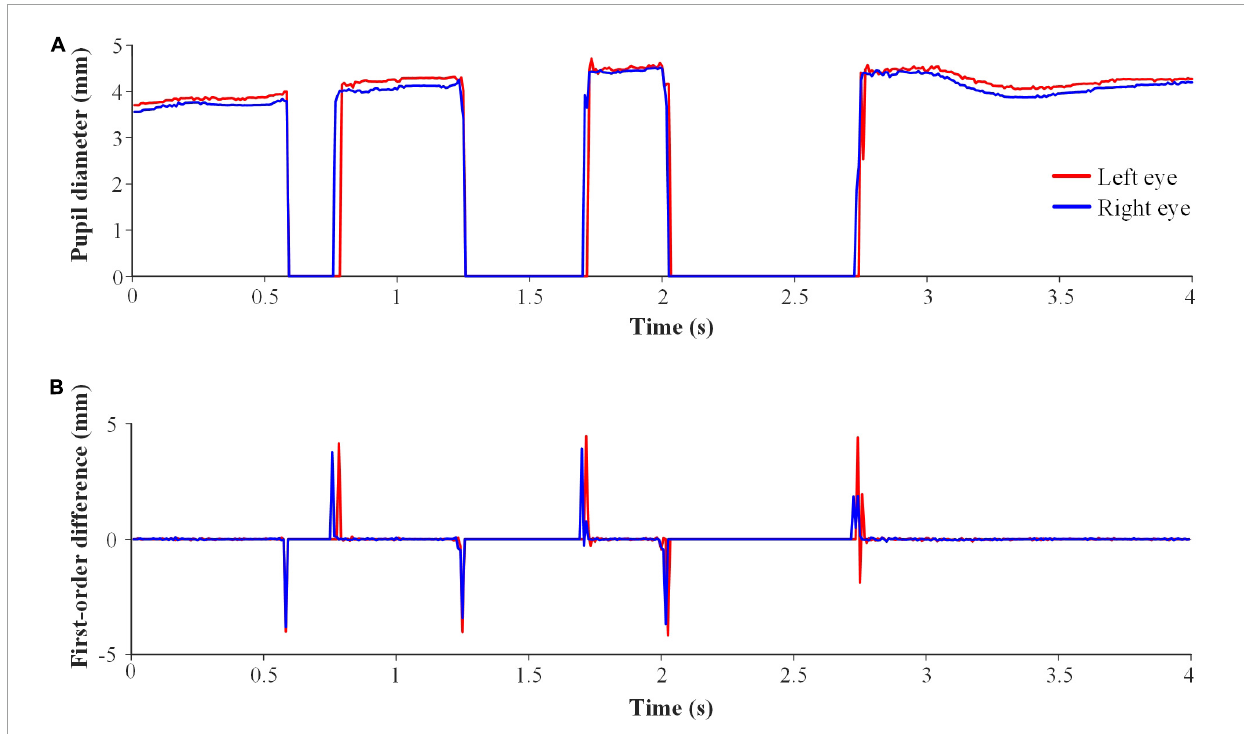
FIGURE4 Schematic diagram of triple blink data. (A) Original pupil diameter. (B) First-order